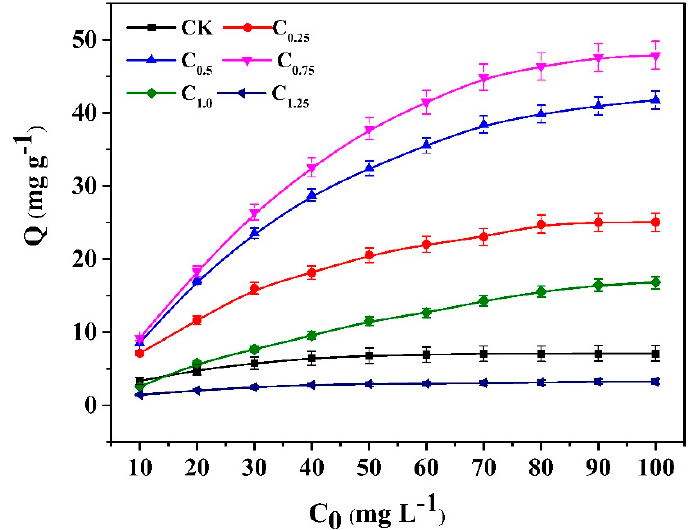
Figure 7. Adsorption isotherm curves of the raw and cystamine-modified biochars for Cd (II).